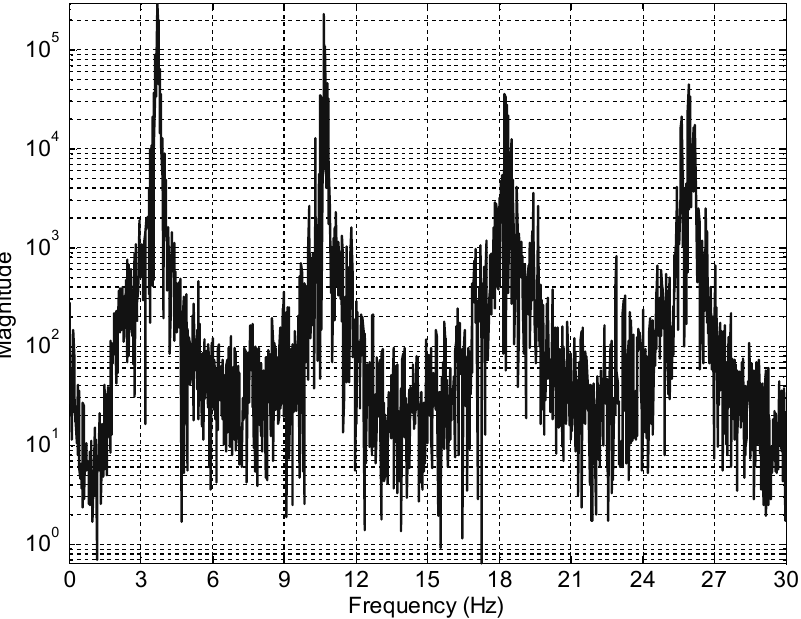
Fig. 7. Dominant singular value for output PSD, DC0